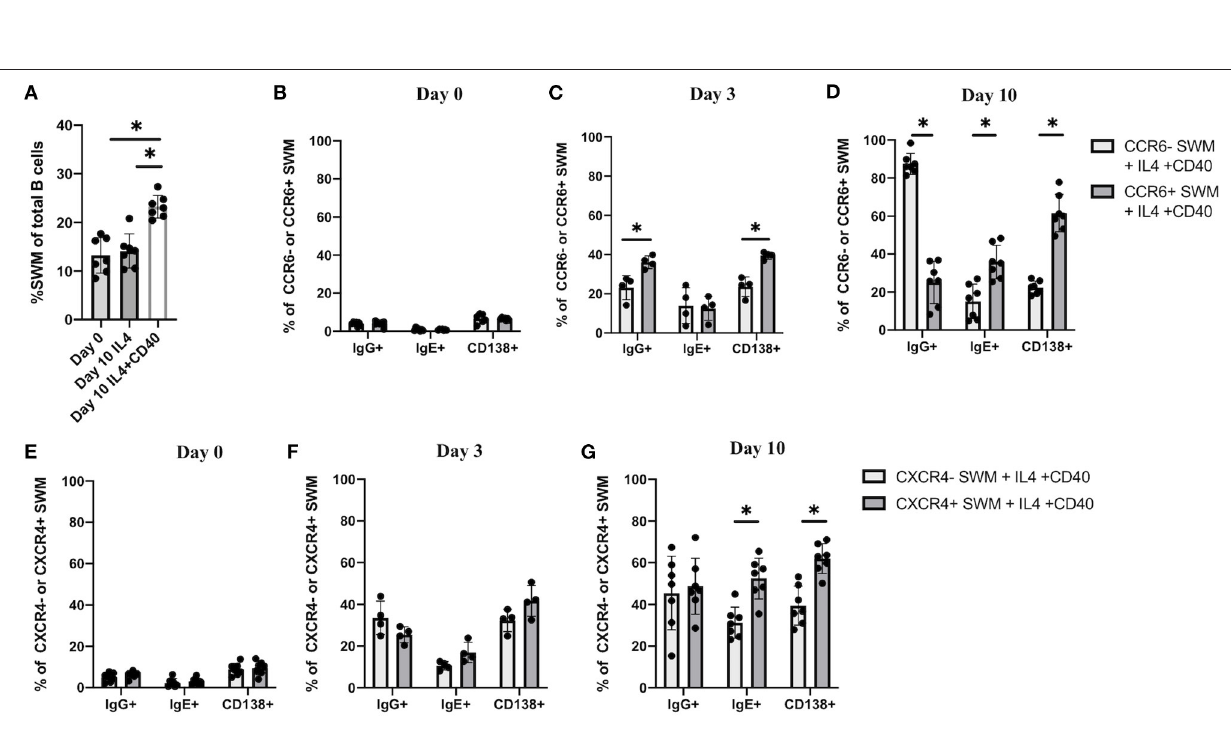
measured both in CCR6- and CCR6 + SWM under conditions of IL4 and anti-CD40 treatment ± CCL20. After 3 days of culture, CCL20 augmented AID expression in the CCR6 + SWM but not the CCR6- SWM B cells ( Figure 5C ; Supplementary Figure 5 ), while no change in cell proliferation was observed ( Figure 5D ). These findings suggested that CCL20/CCR6 intrinsic signaling induced AID